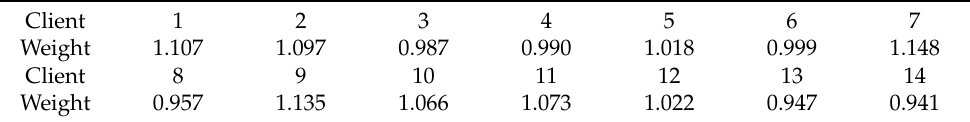
Table 4. The weight value of the first iteration of each